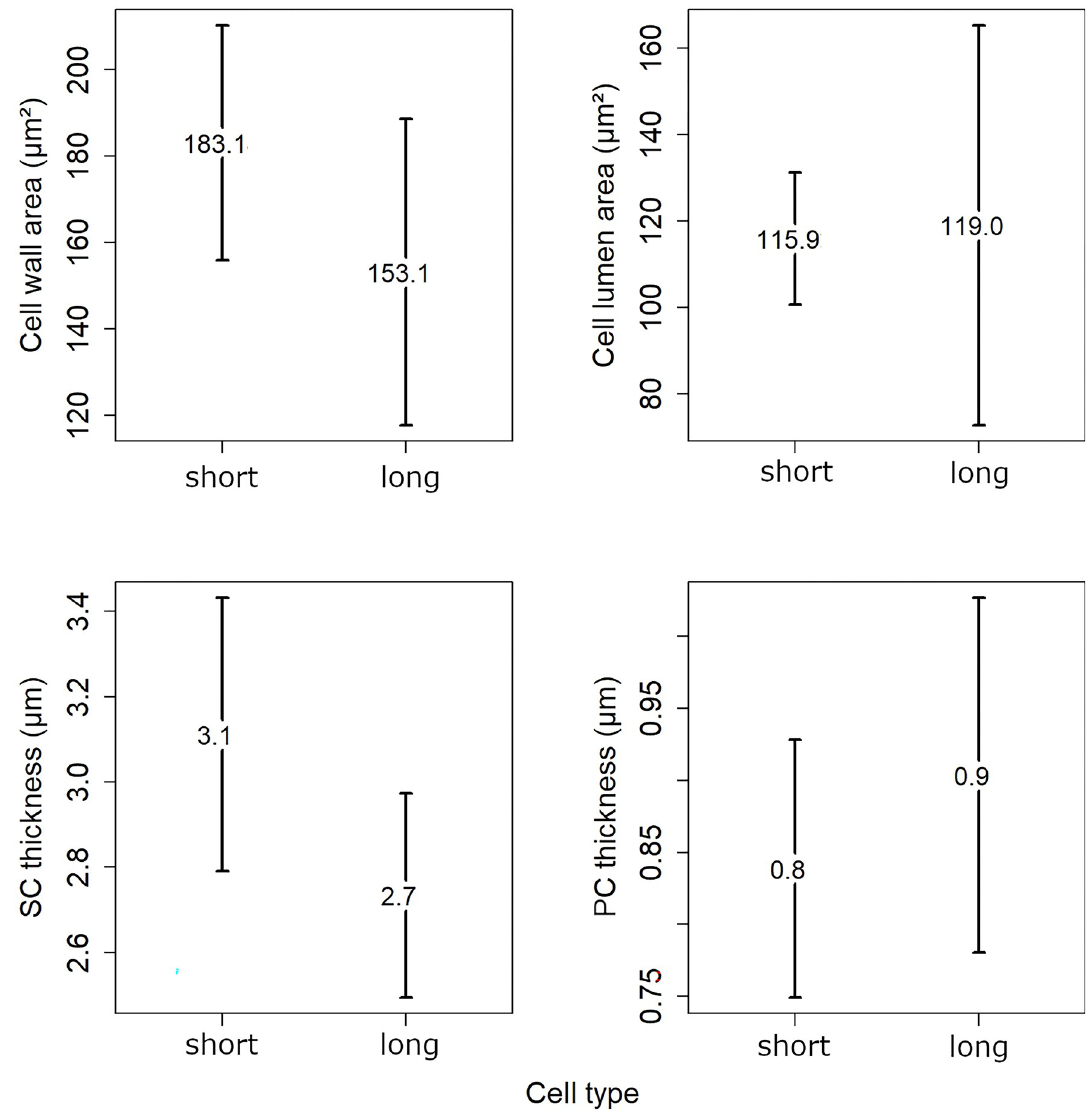
Fig 10. Comparison of mean values for short and long cells in L . racemus DB867. The numbers inside the plots indicate the mean values for the cell wall area, cell lumen area, SC thickness and PC